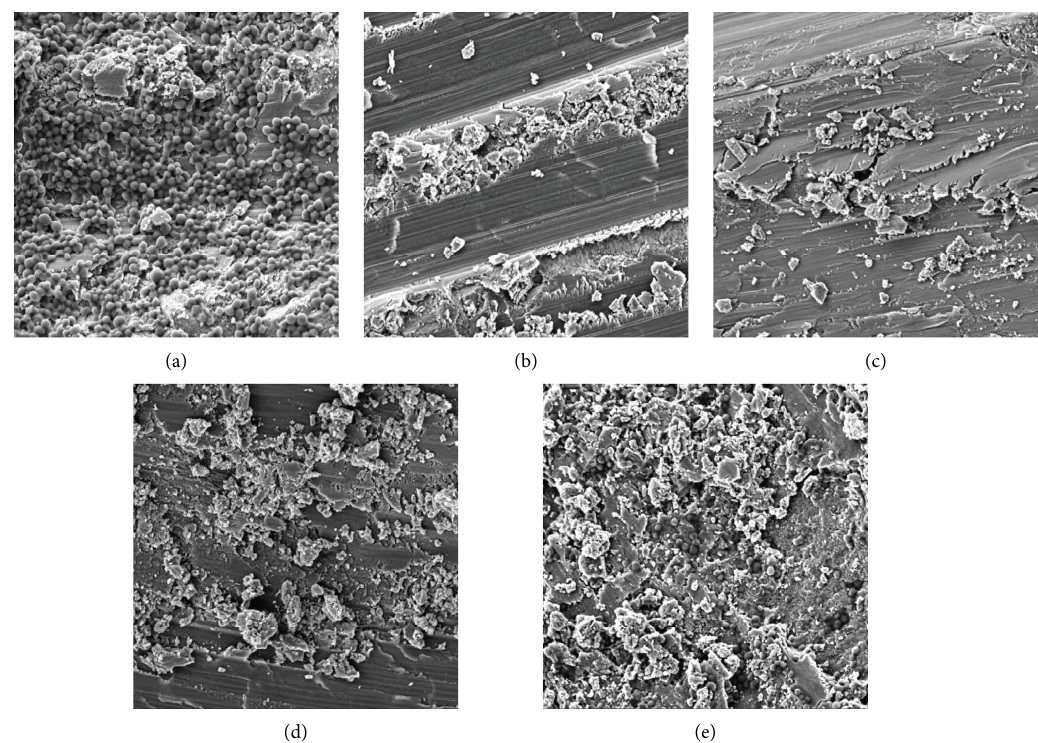
Figure 6: Exposure of GA-AgNPs_0.4g to S . mutans inhibits bacterial adhesion on the enamel surfaces. (a) Tooth enamel with S . mutans without treatment, (b) with GA-AgNPs_0.4g with S . mutans , (c) GA-AgNPs_0.4g without bacteria, (d) S . mutans and CHX D), (e) tooth enamel without bacteria and